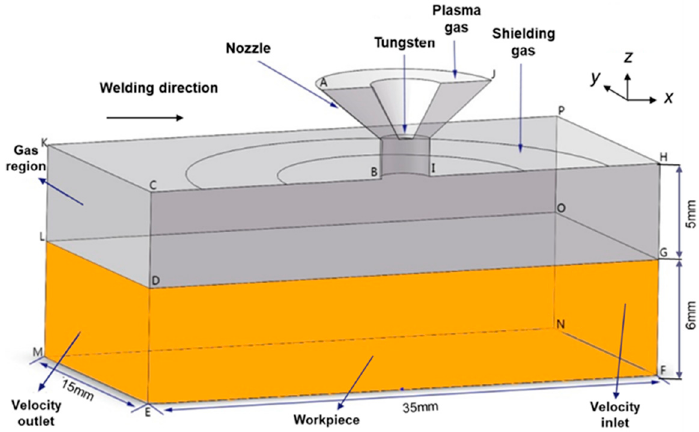
Figure 2. Calculation domain of the unified plasma arc welding (PAW) model.